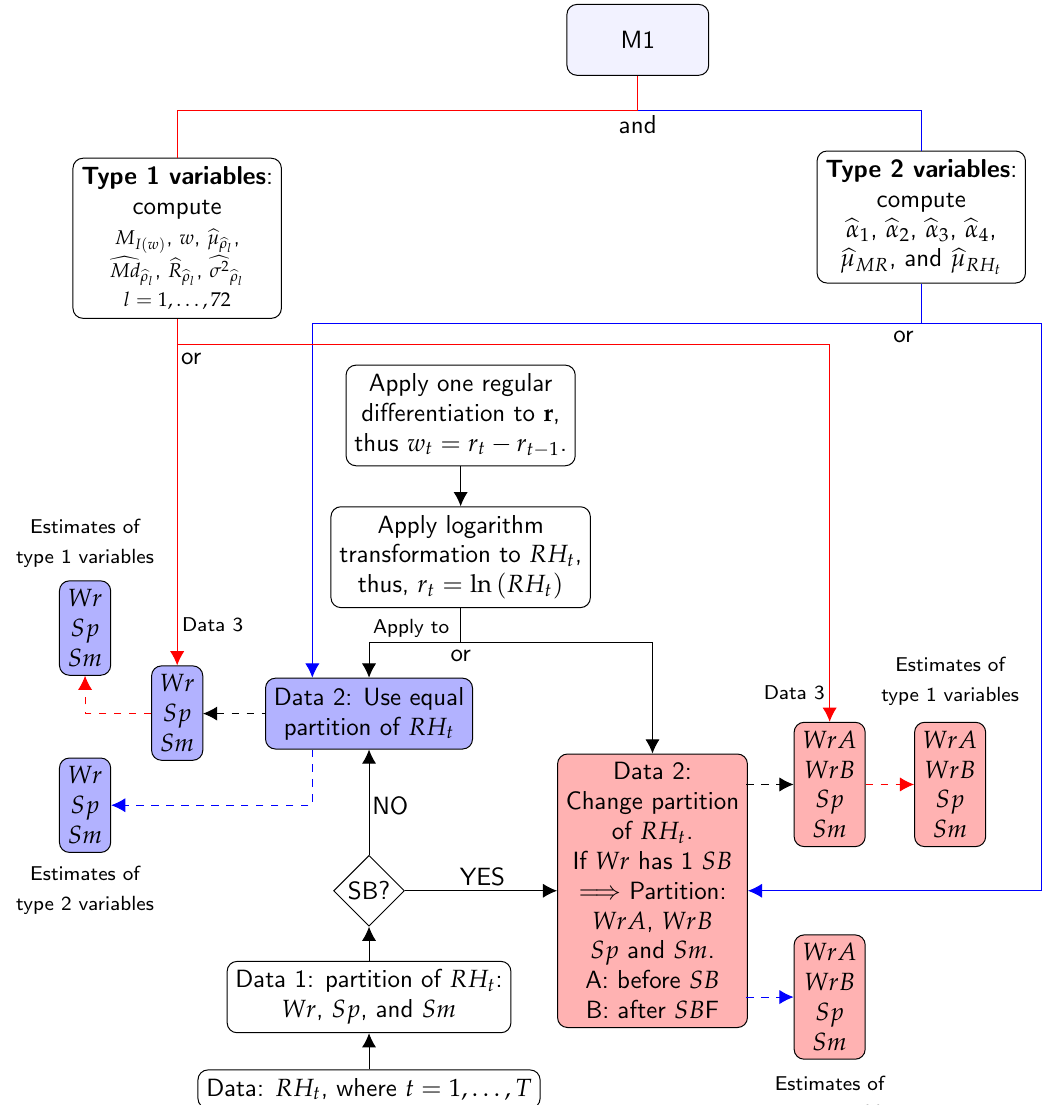
Figure 4. Flow chart for the steps of method 1: Blue lines indicate type 2 variables. Red lines indicate type 1 variables. Solid lines indicate processes. Dashed lines indicate results. The first step consists of dividing the different time series according to the climatic conditions: Wr, Sp, and Sm (Data 1). The second step consists of dividing the time series (Data 1) according to possible structural breaks (SBs) (Data 2). The third step applies a logarithm transformation and one regular differentiation to Data 2. The result is Data 3. The fourth step consists of applying the formulas of type 2 variables to Data 2. This is the first result. The fifth stage is carried out by applying the formula of type 1 variables to Data 3. The outcome produced is result 2. Different boxes contain symbols such as Wr, Sp, and Sm (or WrA, WrB, Sp, and Sm). They indicate that the results were computed for all different parts of the time